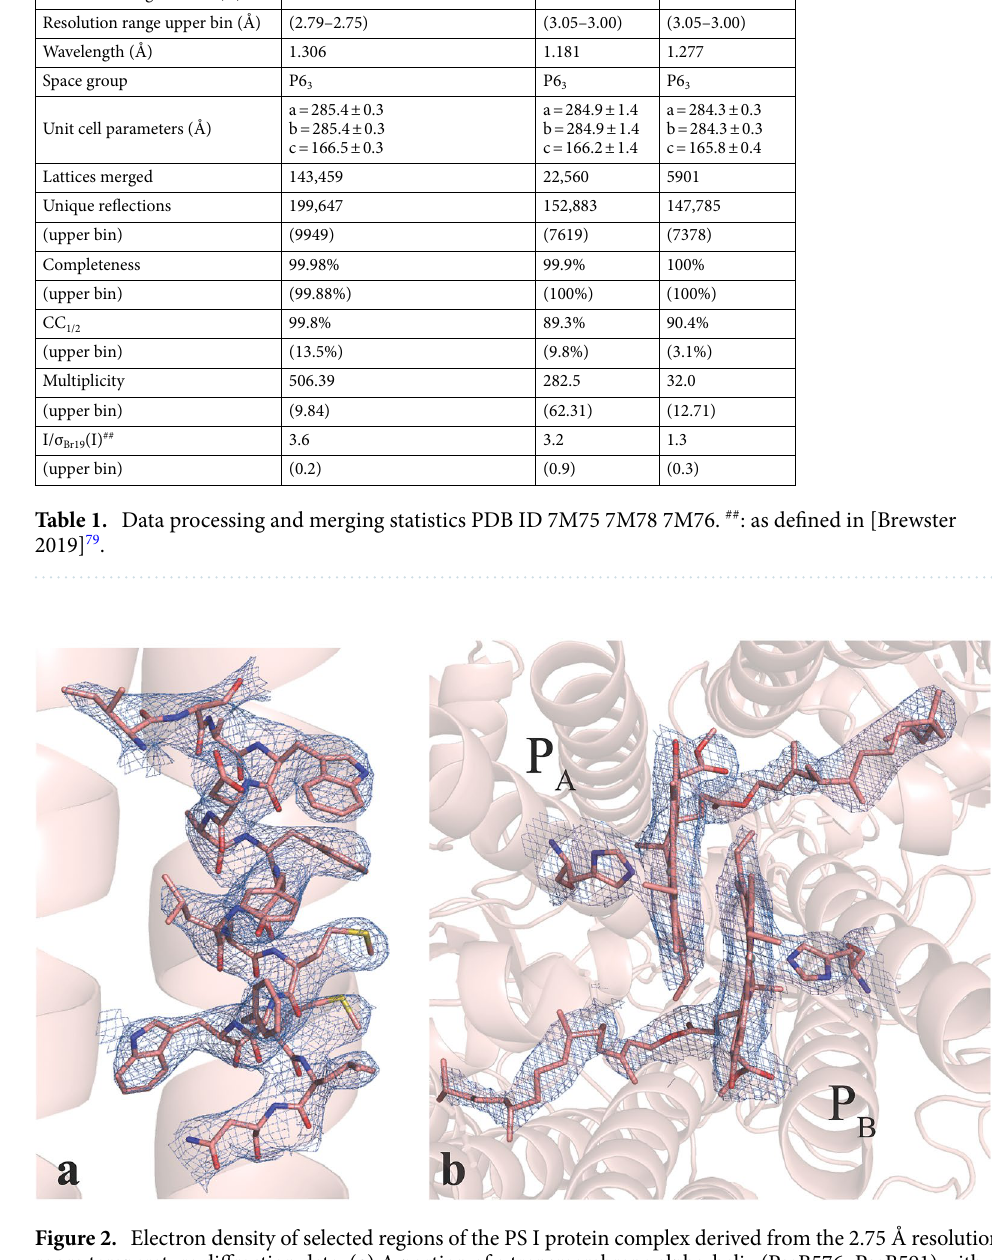
Figure 2. Electron density of selected regions of the PS I protein complex derived from the 2.75 Å resolution room temperature diffraction data. ( a ) A portion of a transmembrane alpha-helix (PsaB576–PsaB591) with side chains modeled into 2F obs − F calc electron density contoured to 1.5 σ . Side chains are clearly visible in this region of the map. ( b ) Electron density in the region of the special pair P700 formed by a Chl a (labeled P B ) and a Chl a’ (labeled P A ). Mg 2+ coordinating His residues and the Chls are shown as sticks, the 2F obs − F calc electron density is shown as blue mesh contoured at 1.5 σ . Figure generated with Pymol v. 2.4.0a0, https:// pymol.